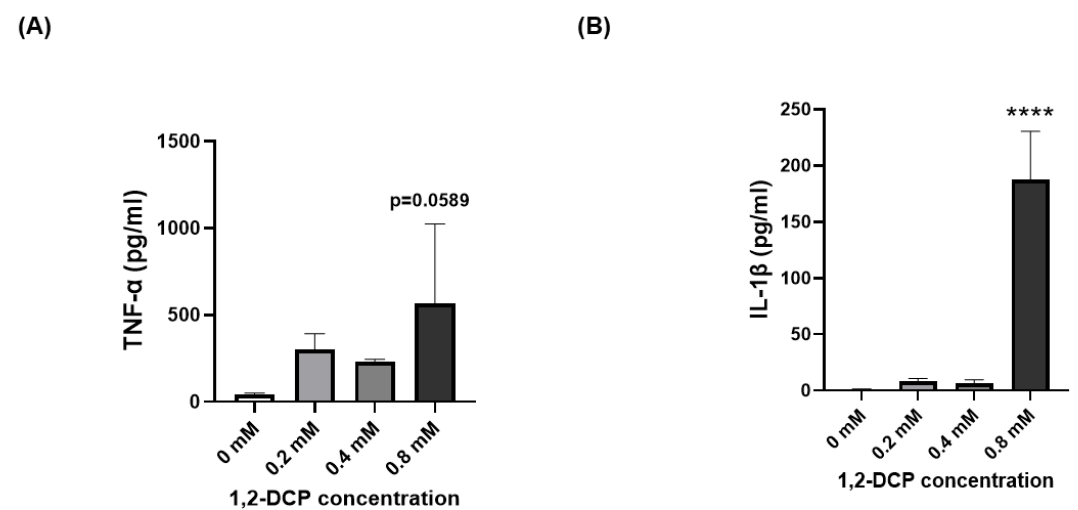
Figure 8. Effects of 1,2-DCP on TNF- α and IL-1 β protein expression in THP-1 macrophages. THP-1 macrophages were exposed to 1,2-DCP at 0, 0.2, 0.4, and 0.8 mM for 24 h, and cell culture supernatants were collected. Protein expression was measured by ELISA. ( A ) TNF- α , ( B ) IL-1 β . Data are mean ± SD, n = 3. **** p < 0.0001 compared with the control group (0 mM), by one-way ANOVA followed by Dunnett’s multiple comparison test.